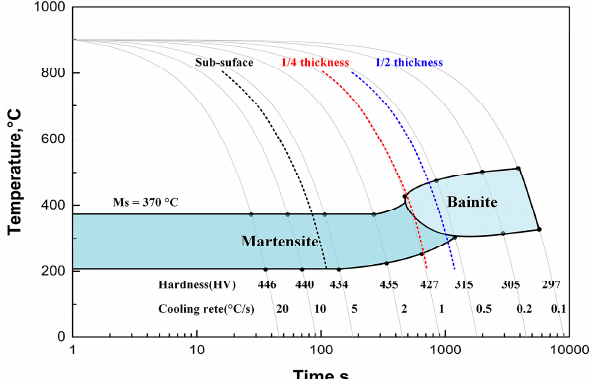
Figure 13. CCT diagram superimposed with the schematic cooling rate at different positions derived from Figure 12.